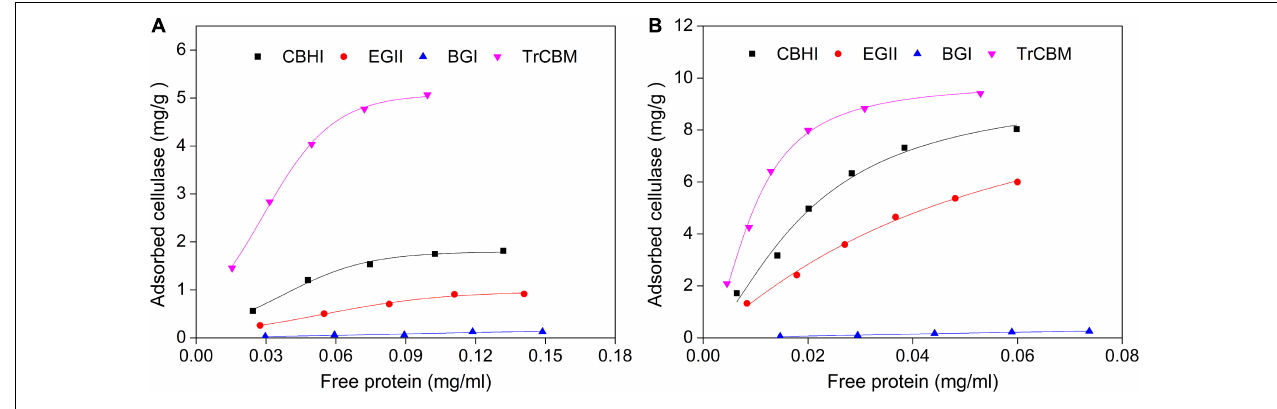
FIGURE 5 | Langmuir isotherm adsorption models of CBHI, EGII, and BGI from P. oxalicum and TrCBM on FP (A) and lignin extracted from LPCS (B) .